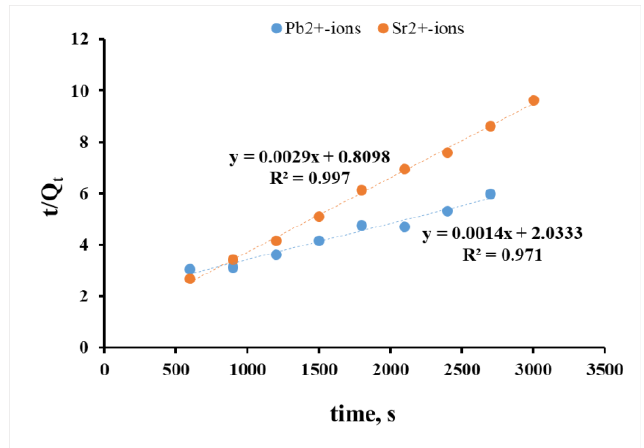
Figure 7. Sorption kinetics of Pb 2+ and Sr 2+ ions in the coordinates of the Ho and McKay pseudo- second-order.